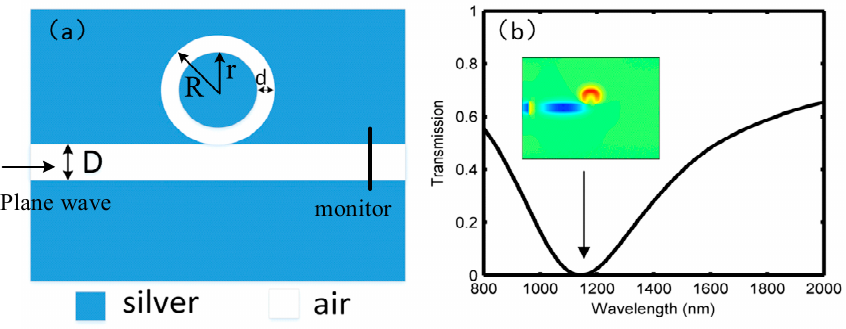
Figure 1. ( a ) Single ring resonator structure; and ( b ) transmission